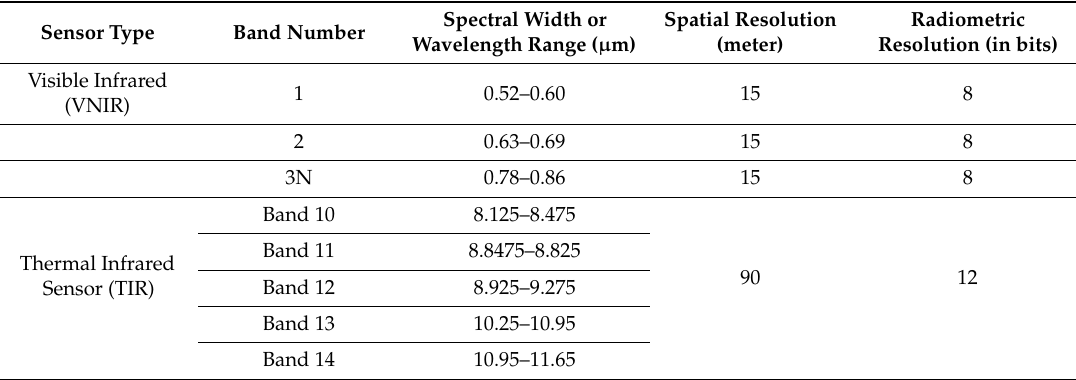
Table 1. ASTER thermal infrared (TIR) data specifications (here visible–near-infrared (VNIR) bands are used for preparing the study area map while data processing is restricted to TIR bands). Band 6 to Band 9 are part of ASTER short wave infrared(SWIR) region. These SWIR spectral bands are not used in this